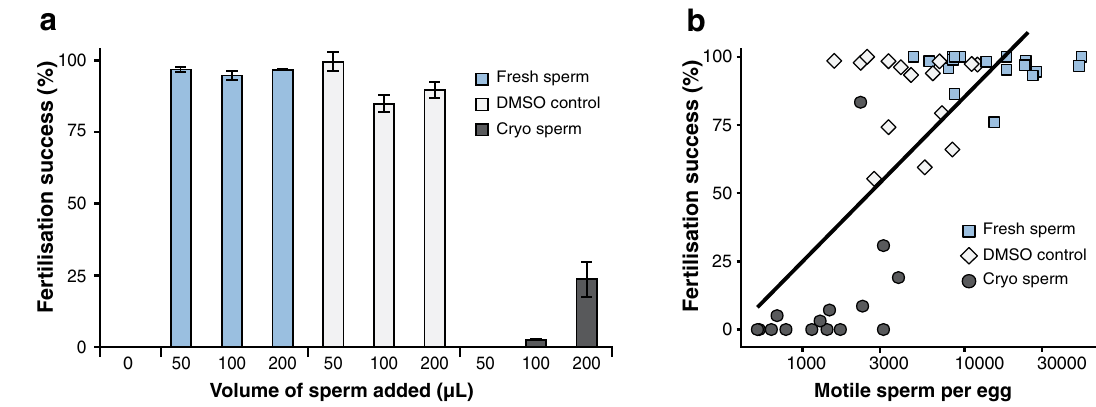
Figure 6. Lobactis scutaria reproduction. ( a ) When fresh sperm and fresh sperm + 10% DMSO were added to fresh eggs, the reproductive success was > 75% across all fresh sperm treatments. However, during cryopreservation the motile concentration was reduced by a factor of 10, thereby reducing the egg:sperm ratio to 1:5400 and 1:13,000 of motile sperm for the successful cryo trials. ( b ) Understanding the motile concentration of cryopreserved sperm and obtaining accurate egg:sperm ratios are critical for predicting robust fertilisation success with thawed sperm samples. This figure shows correlation between motile sperm concentration per egg (x-axis, logarithmic scale) and fertilisation success (y-axis) in eggs fertilised by fresh sperm in FSW, fresh sperm in 10% DMSO, and cryopreserved sperm in 10% DMSO. The correlation coefficient r between the two variables is 0.75 ( P = 8.6 × 10 −10 ). Fresh sperm samples from 6 males were pooled and mixed with individual females (n = 6). One and two data points are missing in the fresh sperm + 10% DMSO, 100 and 200 µL categories, respectively. Bars in panel a are SE.